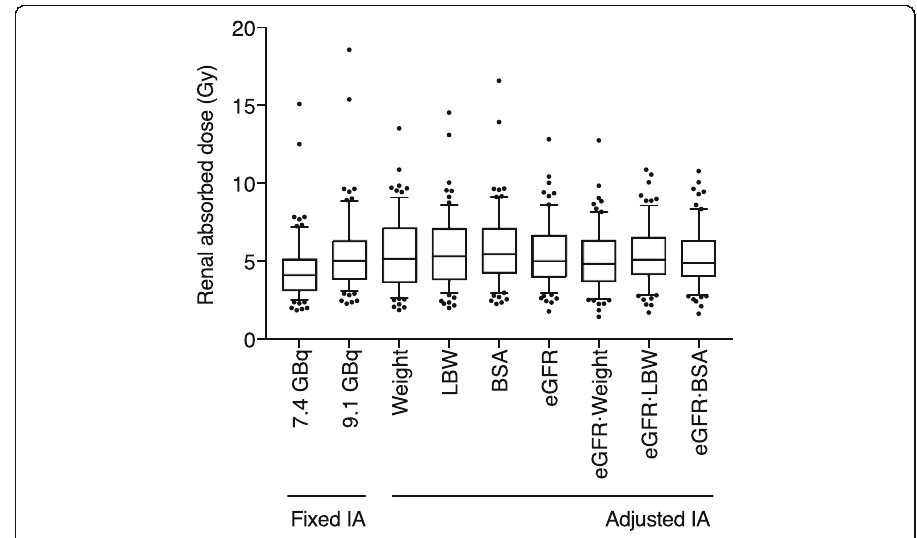
Fig. 6 Comparison of renal absorbed dose delivered during the first cycle of fixed injected activity (IA) vs. personalized PRRT regimes ( n = 77). In the latter, the prescribed renal absorbed dose is 5 Gy and the IA is adjusted based on weight, lean body weight (LBW), body surface area (BSA), estimated glomerular filtration rate (eGFR), or the product of eGFR and of a body size descriptor. For comparison, a fixed IA of 9.1 GBq would yield a median renal absorbed renal absorbed dose of 5